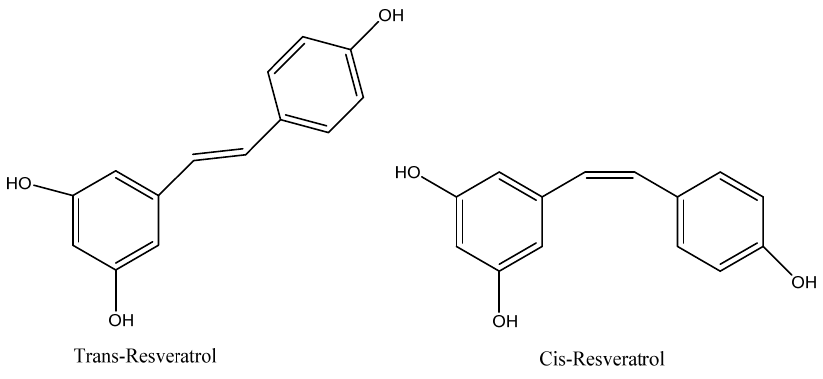
Figure 1. Resveratrol isomers.